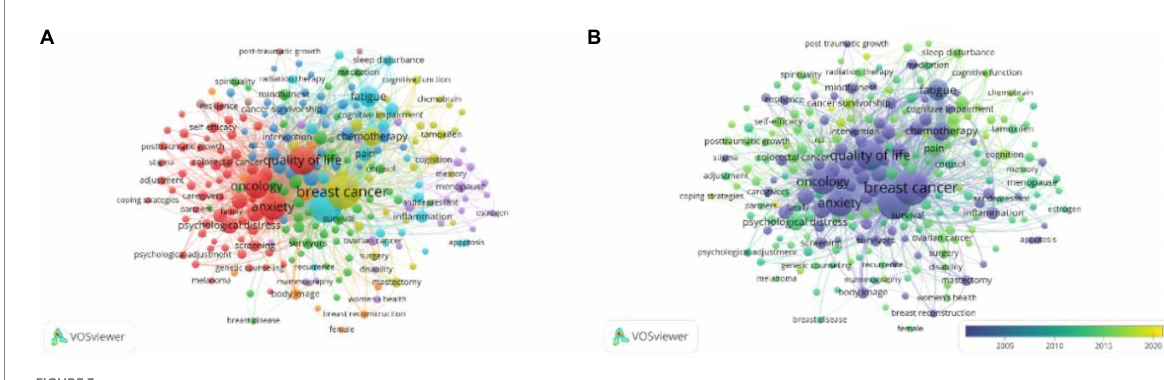
FIGURE 3 A visualization network of collaboration between countries and regions.